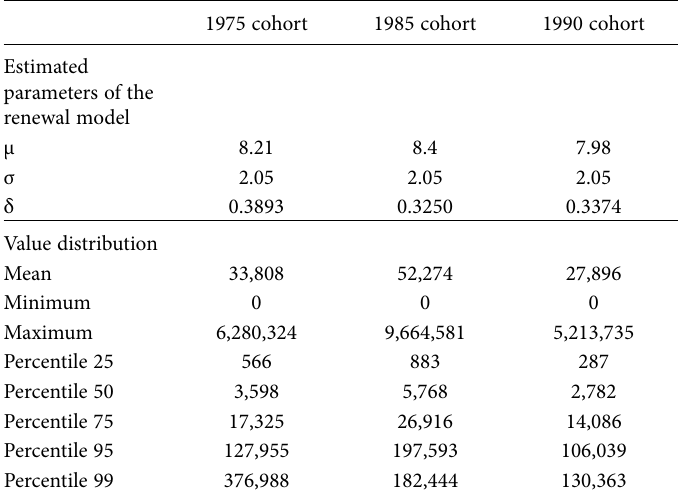
Table 8. Estimates of the private value distribution of PVP certificates for ornamental crops in the UK (all values in constant 2003 UK